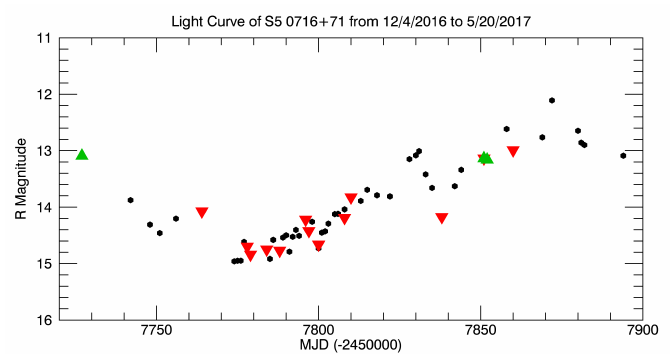
Figure 1. Light curve of S5 0716+71 from 4 December 2016 to 20 May 2017. Each black dot represents a night of observation. The green triangles represent nights with detected micro-variability while the red (inverted) triangles represent nights